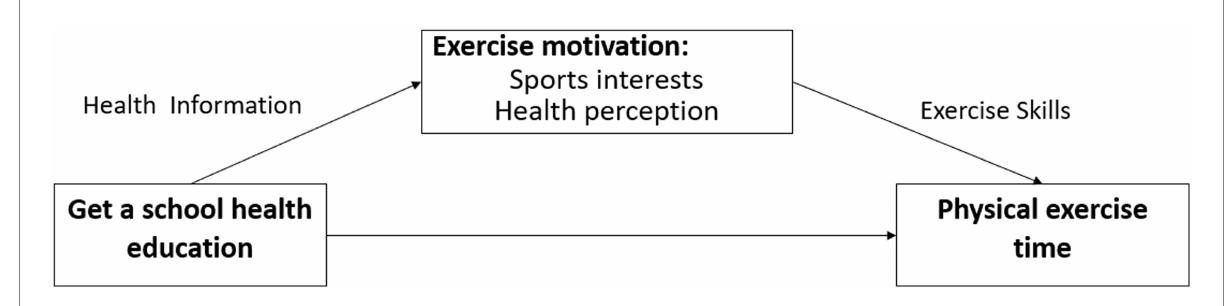
FIGURE 1 The “Information-Motivation-Behavioural Skills” model of school health education affects students’ physical